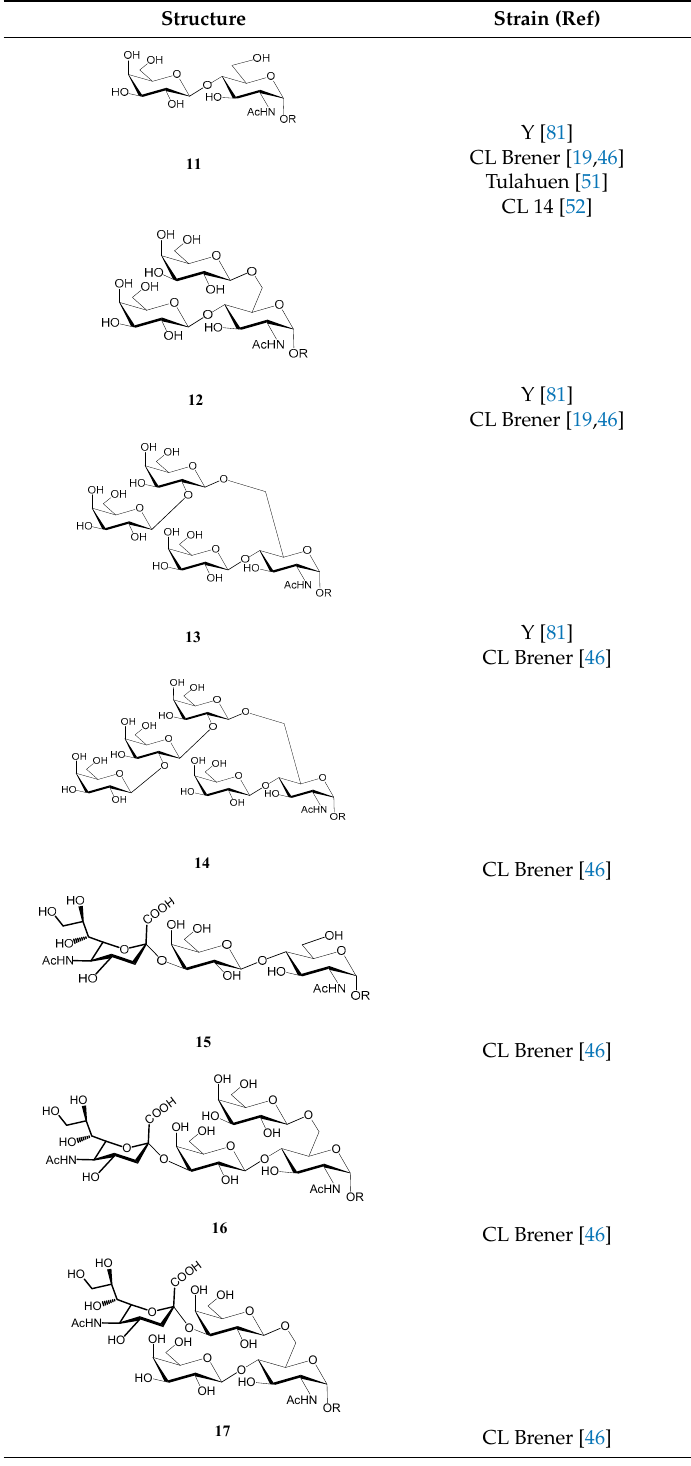
Table 2. O -linked carbohydrates derived from core 1 in the mucins of T. cruzi.